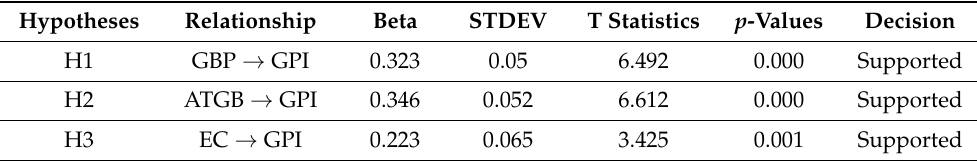
Table 9. Direct relationship